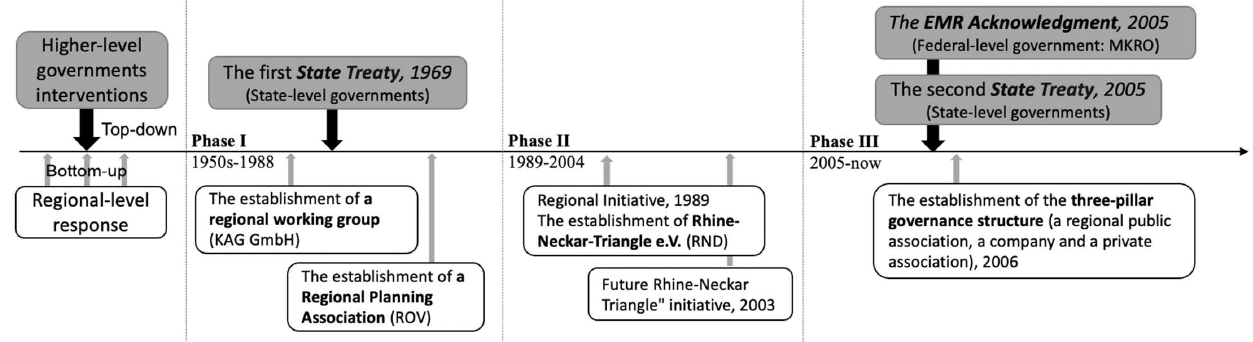
Figure 5. Historical regional interventions in the Rhine–Neckar Metropolitan Region (MRN). Source: the authors.